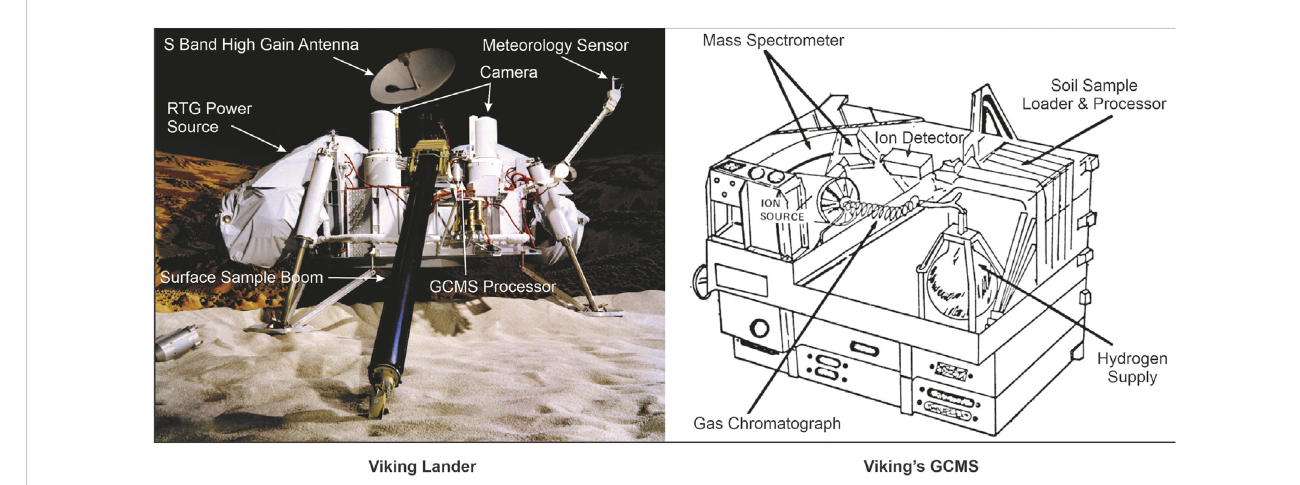
FIGURE 1 Viking Lander and GCMS instruments [sources: Huidobro et al. (2022) and NASA